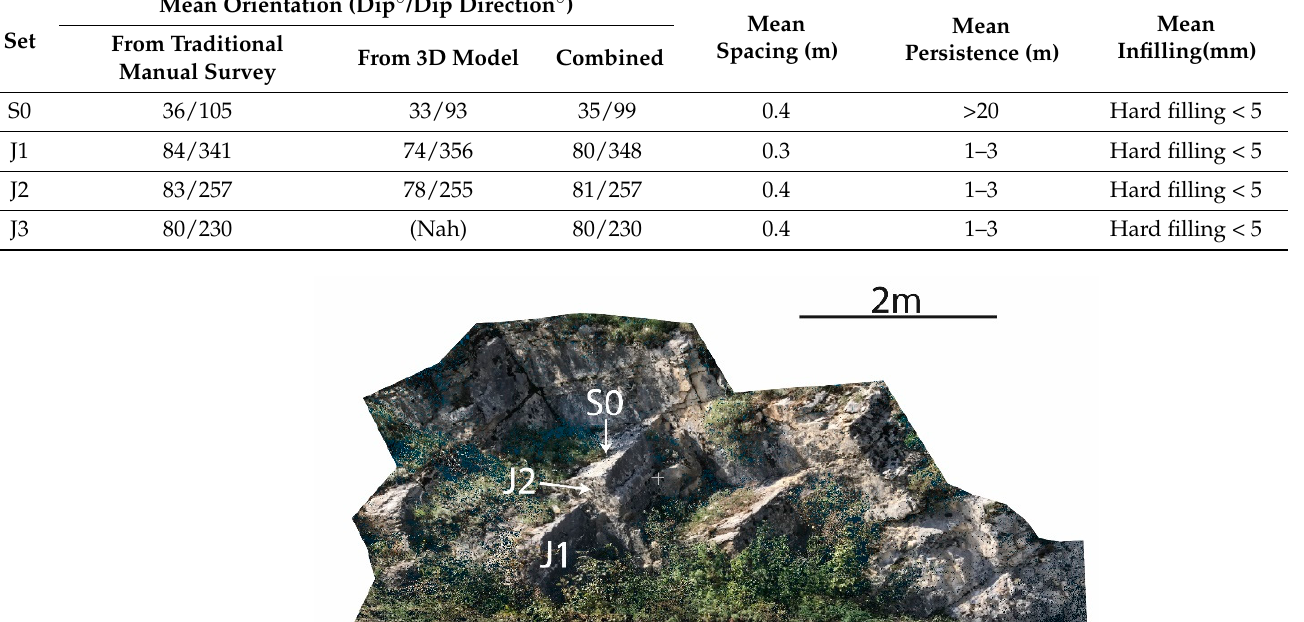
Table 5. Properties of identified discontinuity sets, including the mean orientations obtained from the traditional manual survey, mean orientations obtained from photogrammetric surveys, mean orientations obtained from the combination of both surveys, mean discontinuity spacing and mean discontinuity persistence.